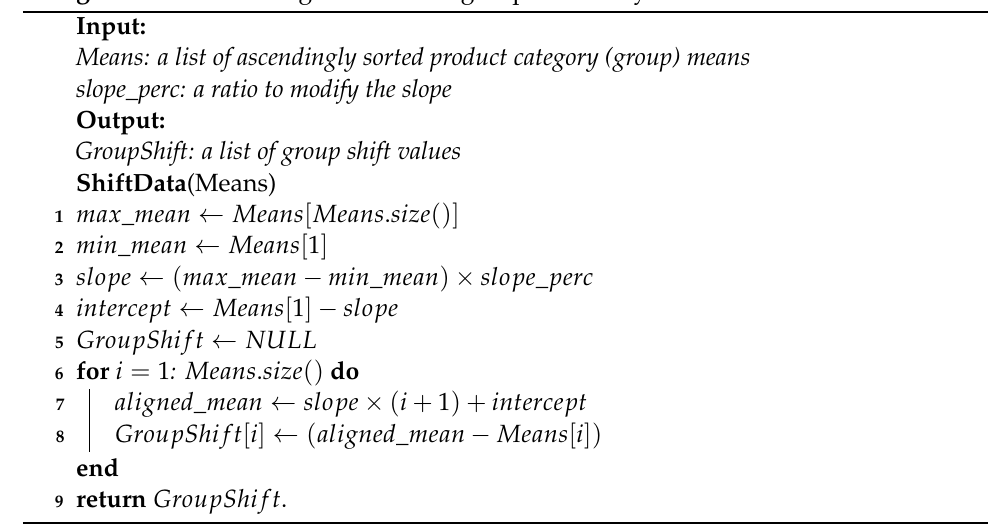
Algorithm 1: Increasing the between-group